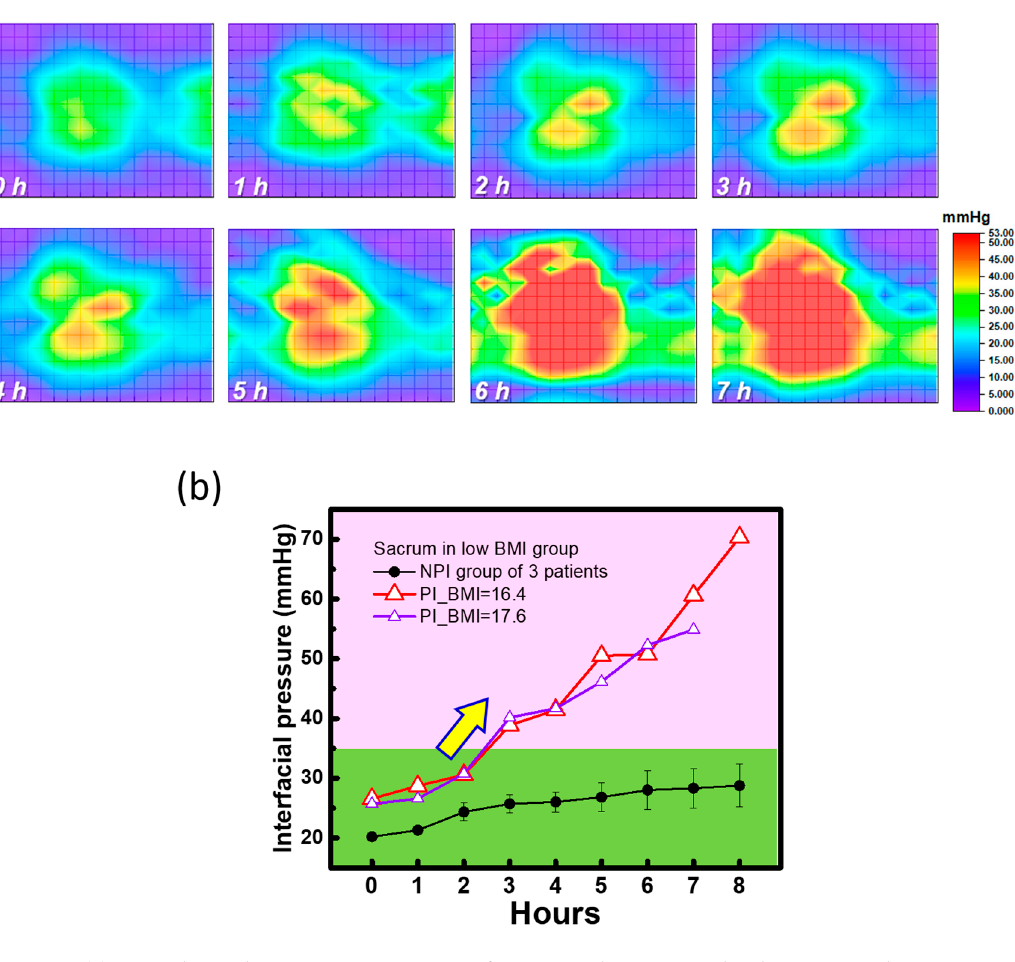
Figure 7. ( a ) Time-dependent 2D pressure image for a typical patient with a low BMI and pressure injury and ( b ) time-dependent pressure trending of the sacrum area for patients with and without pressure injury according to the real measurement in cardiac operations.